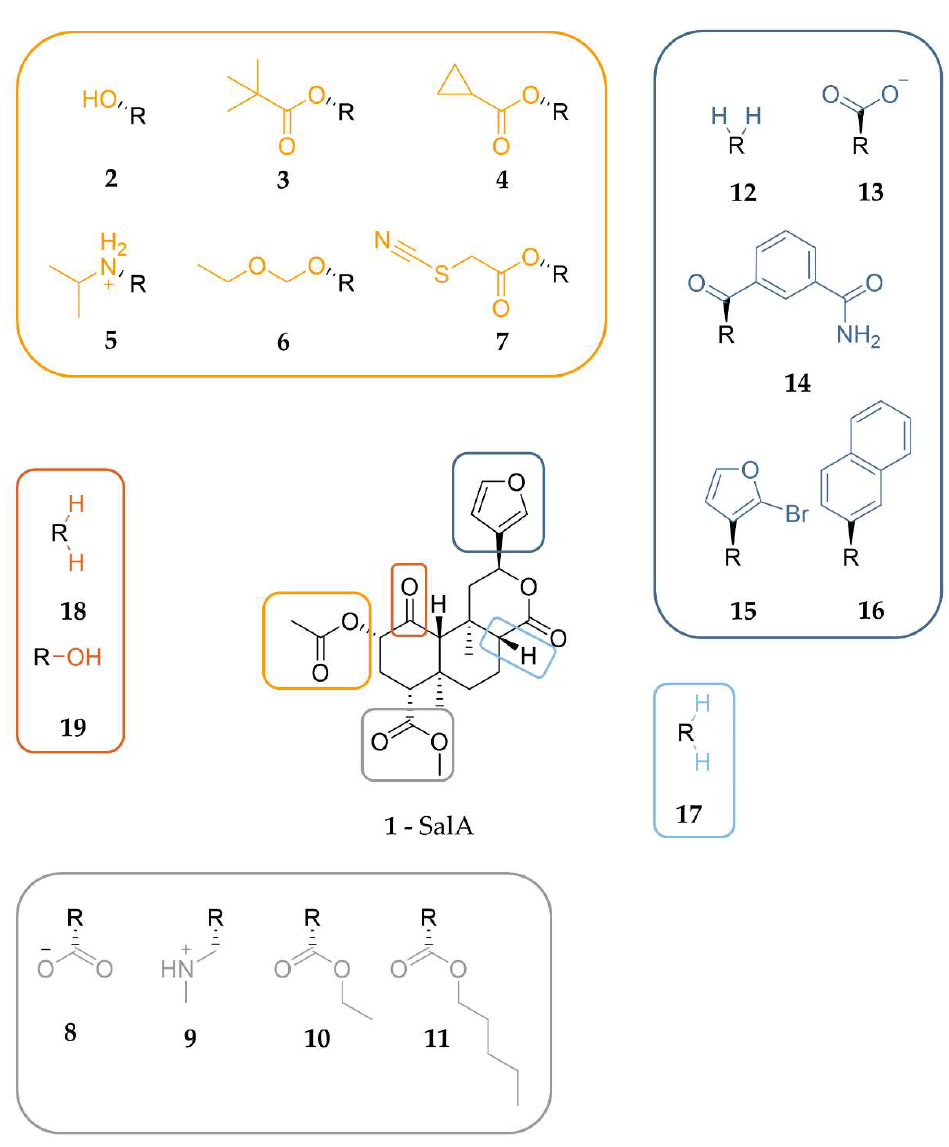
Figure 5. Chemical structure of SalA-analogs discussed to evaluate the proposed binding mode of SalA.